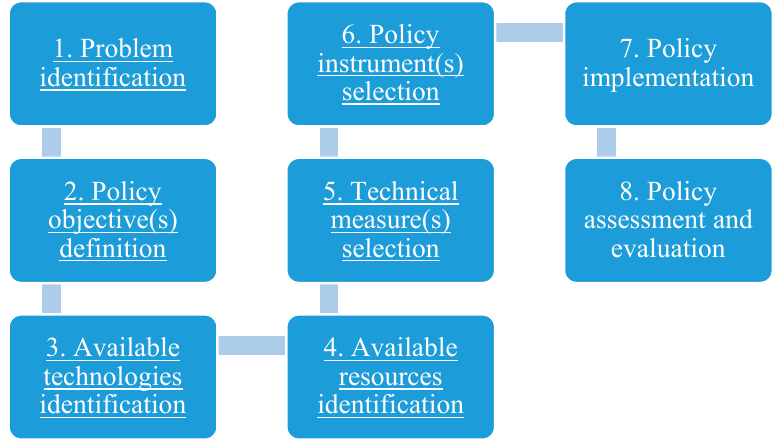
Figure 1. Water Heating System (WHS) Policy Process.